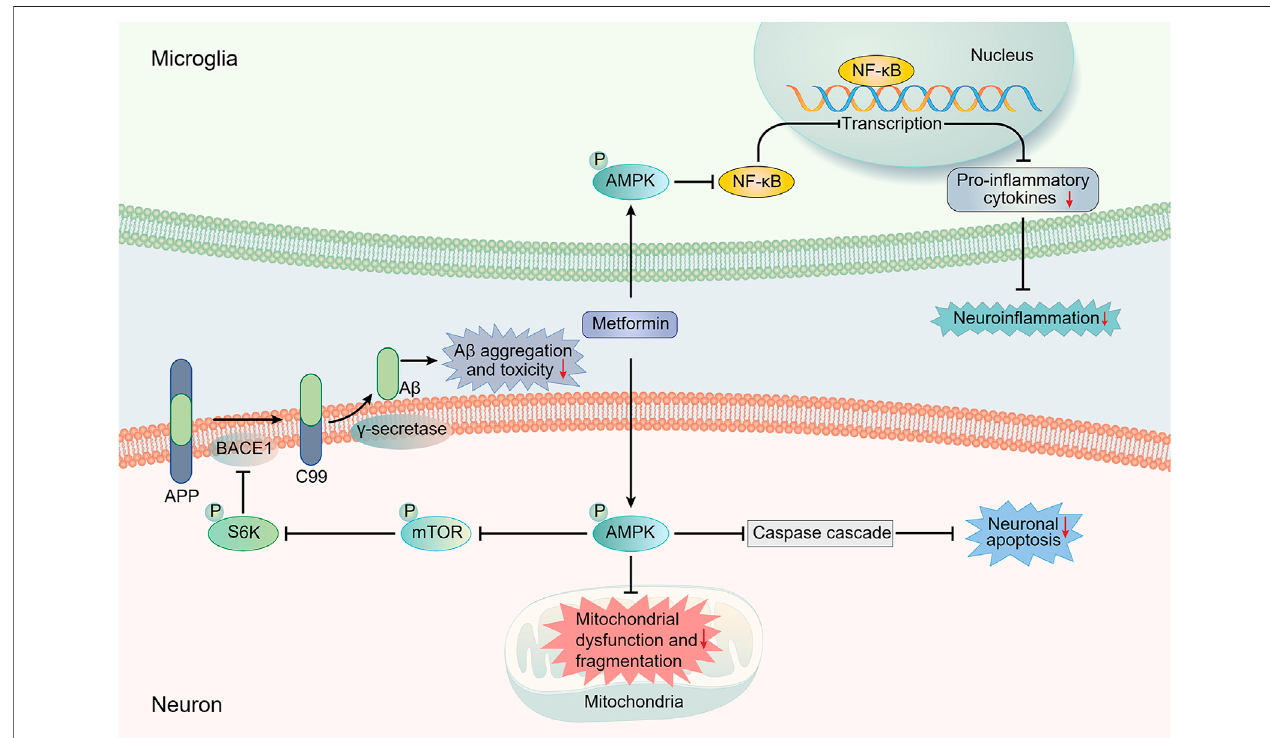
FIGURE 1 | Main potential AMPK-dependent molecule mechanisms involved in the neuroprotective effects of metformin against AD pathology. Most presented mechanistic studies have implied an AMPK-dependentneuroprotective action ofmetformin against AD. The regulation of AMPK/mTOR/S6K/BACE1 signaling pathway by metformin can result in a reduction in A β production, thus decreasing A β toxicity. AMPK activation can also suppress the activation of the NF- κ B pathway, which is regarded as the central signaling pathway involved in AD neuroin fl ammation. Moreover, the increased activation of caspase cascade, which is involved in the apoptosis-mediated neurodegeneration, and the impairment of mitochondrial function and morphology induced by A β can be inhibited by metformin in an AMPK- dependent manner. AMPK, AMP-activated protein kinase; APP, amyloid precursor protein; A β , amyloid- β ; BACE1, β -site APP cleaving enzyme-1; mTOR, mechanistic target of rapamycin; NF- κ B, Nuclear factor-kappa B; S6K, ribosomal S6